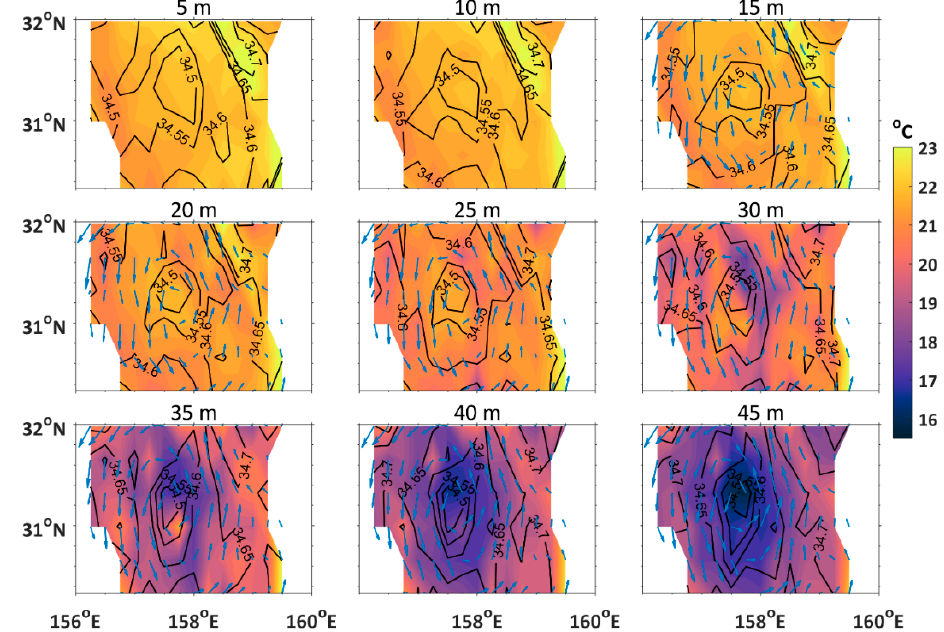
Figure 15. Temperature, salinity and velocity at different depths. Shaded areas indicate temperature. The vectors are velocities measured by the 300 kHz ADCP.